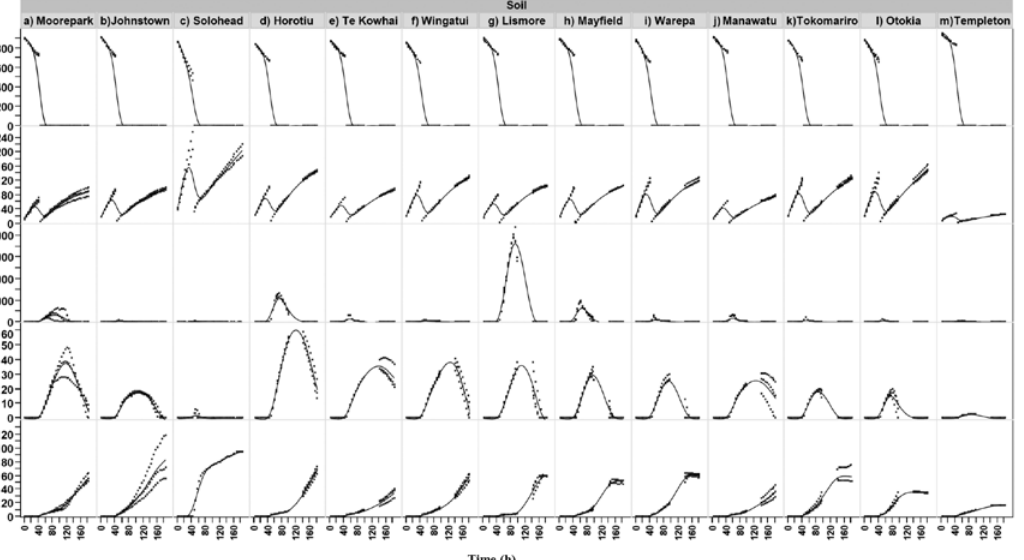
Fig 2. Gas kinetics profile of IR and NZ soils under oxic and anoxic conditions. O 2 , CO 2 , NO, N 2 O and N 2 emission kinetics during incubation of 13 different temperate soils (3 Ireland (a,b,c) and 10 New Zealand (d to m)) amended with 2 mM nitrate (flooding and draining immediately before incubation). Soil samples (20 g dry weight) were incubated under oxic (first 40 hours) and subsequently anoxic conditions. Dots represent three replicate vials and smooth line is the fitted line for all data. doi:10.1371/journal.pone.0151713.g002 PLOS ONE | DOI:10.1371/journal.pone.0151713 March 18,